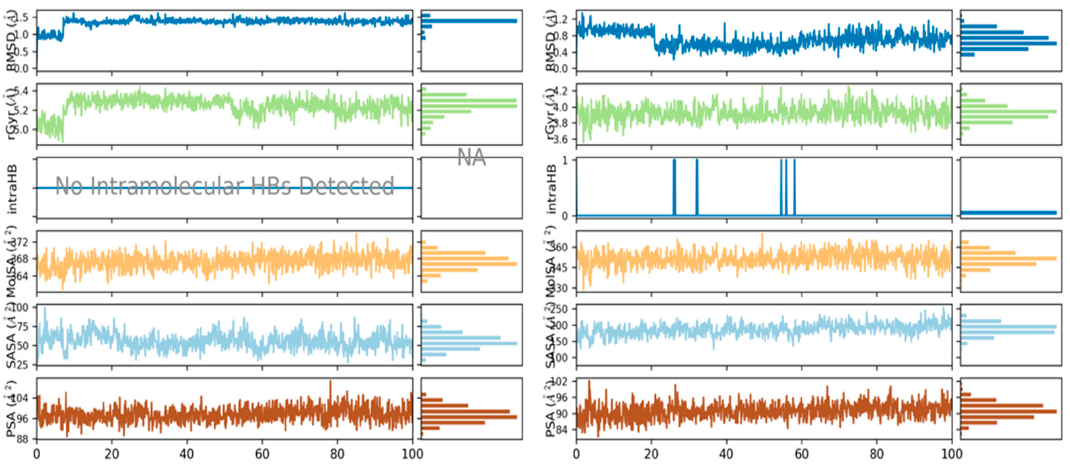
Figure 11. Radius of gyration (Rg), Solvent accessible surface area (SASA) and Intra-molecular hydrogen bonds (IntraHB) graphs of VEGFR 2 and EGFR.